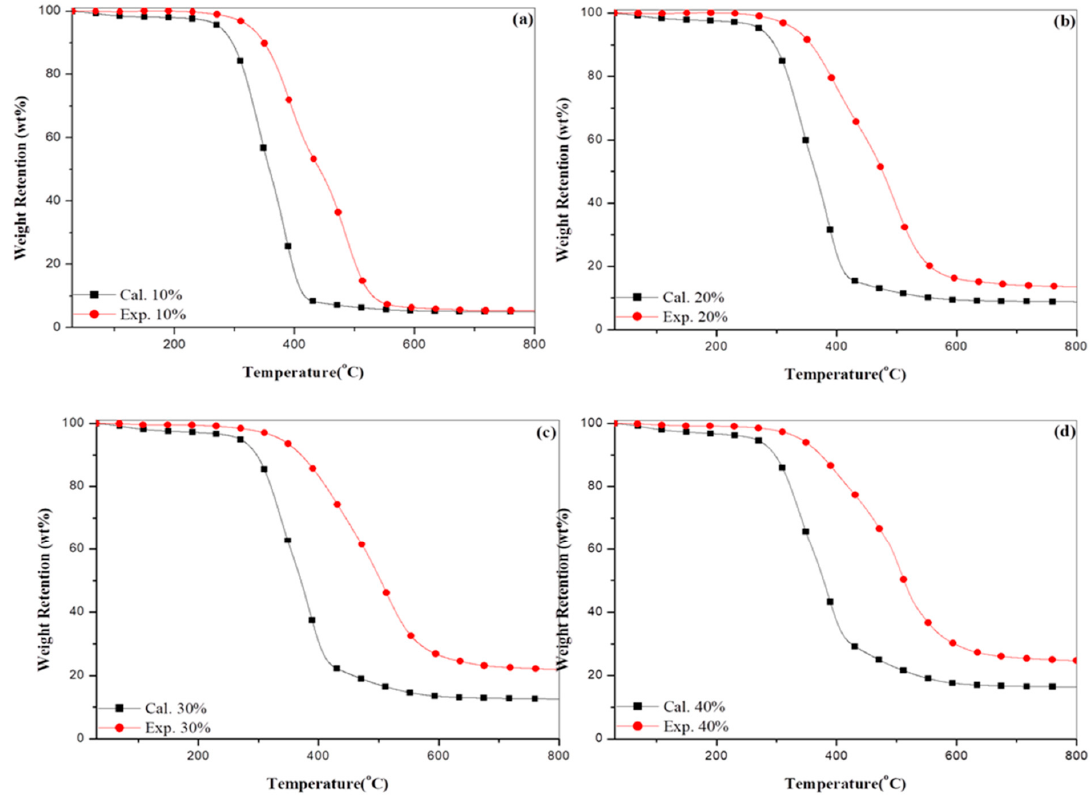
Figure 10. Comparison of calculated and experimental TGA curves for: ( a ) Si-PU/APTS-GPTS 10%; ( b ) Si-PU/ APTS-GPTS 20%; ( c ) Si-PU/ APTS-GPTS 30%; and ( d ) Si-PU/ APTS-GPTS 40% composites. Table 3. Comparison of calculated and experimental TGA data of Si-PU/APTS-GPTS composites. Sample NO.